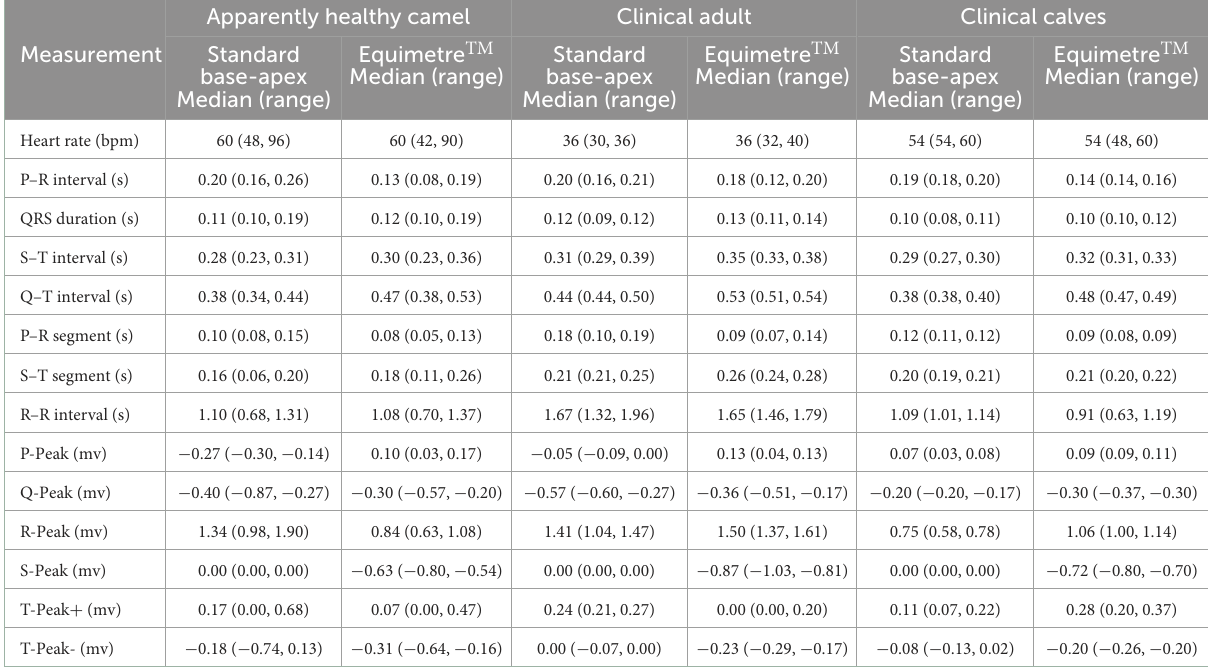
TABLE 2 Summary of ECG measurements for healthy adult, clinical adult, and clinical calves camel. Apparently healthy camel Clinical adult Clinical calves